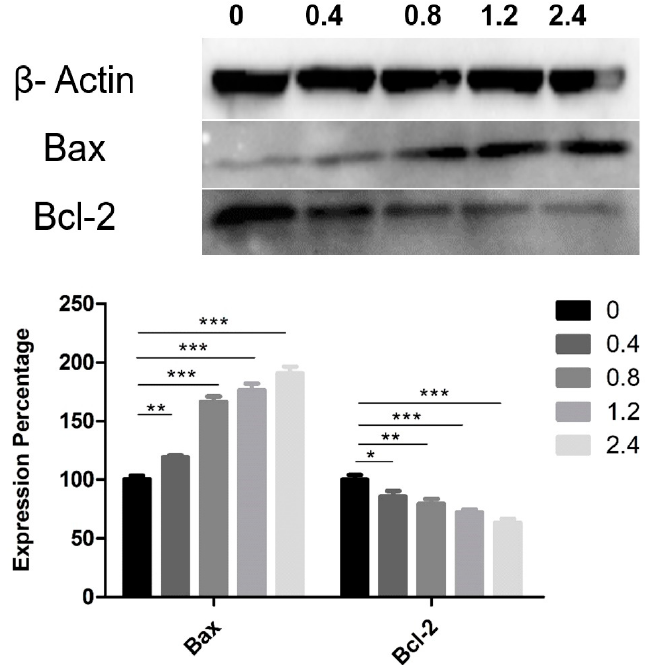
Figure 8. Effect of UD extract on the expression level of Bax and Bcl-2 after 48 h of treatment with different concentrations of UD extract at 0.4, 0.8, 1.2, and 2.4%. β -Actin was used as a loading protein. The graph represents the means from three independent experiments +/ − SEM. *, **, and *** indicate p < 0.05, p < 0.001, and p < 0.0001, respectively, compared to the control group.